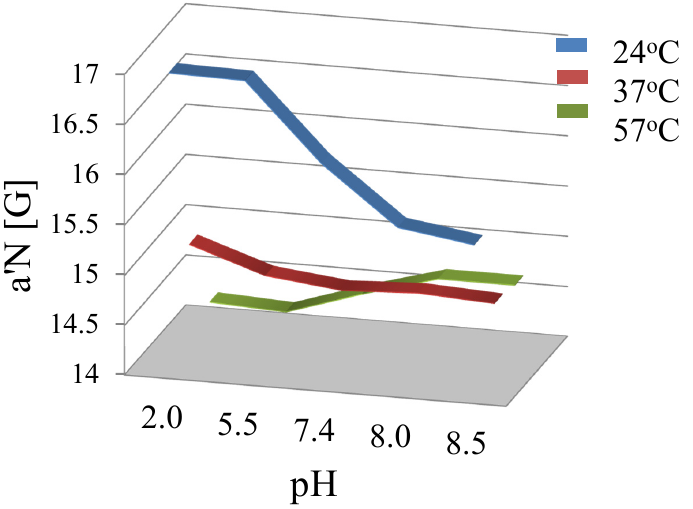
Figure 5. Effect of the pH and temperature on the polarity and the motion of spin marker 5-DOXYL along the perpendicular to the surface of membrane.